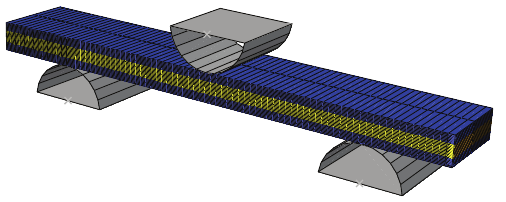
Figure6:Finiteelementmeshusedforthesimulationofthe3point- bending flexural tests.